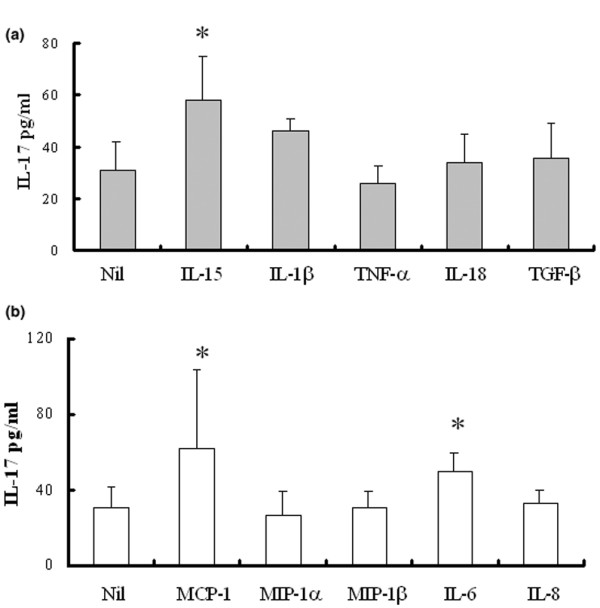
Production of interleukin (IL)-17 by peripheral blood mononuclear cells (PBMC) from patients with rheumatoid arthritis (RA). (a) Production of IL-17 by cytokine induction. PBMC from patients with RA were stimulated for 24 hours with IL-15 (10 ng/ml), IL-1β (10 ng/ml), tumor necrosis factor-α (TNF-α; 10 ng/ml), IL-18 (10 ng/ml) and transforming growth factor-β (TGF-β; 10 ng/ml). Levels of IL-17 were measured in culture supernatants by enzyme-linked immunosorbent assay. Each value represents the mean and SEM of three independent experiments. (b) Production of IL-17 by chemokine induction. PBMC were cultured in the presence of monocyte chemoattractant protein-1 (MCP-1; 10 ng/ml), macrophage inflammatory protein-1α (MIP-1α; 10 ng/ml), MIP-1β (10 ng/ml), IL-6 (10 ng/ml) and IL-8 (10 ng/ml). *, P < 0.05.